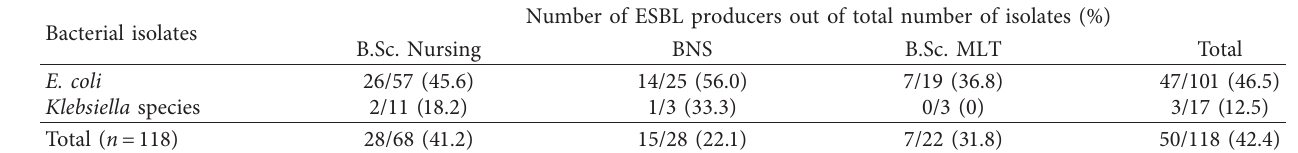
Table 4: ESBL carriage among different programs of HS students.